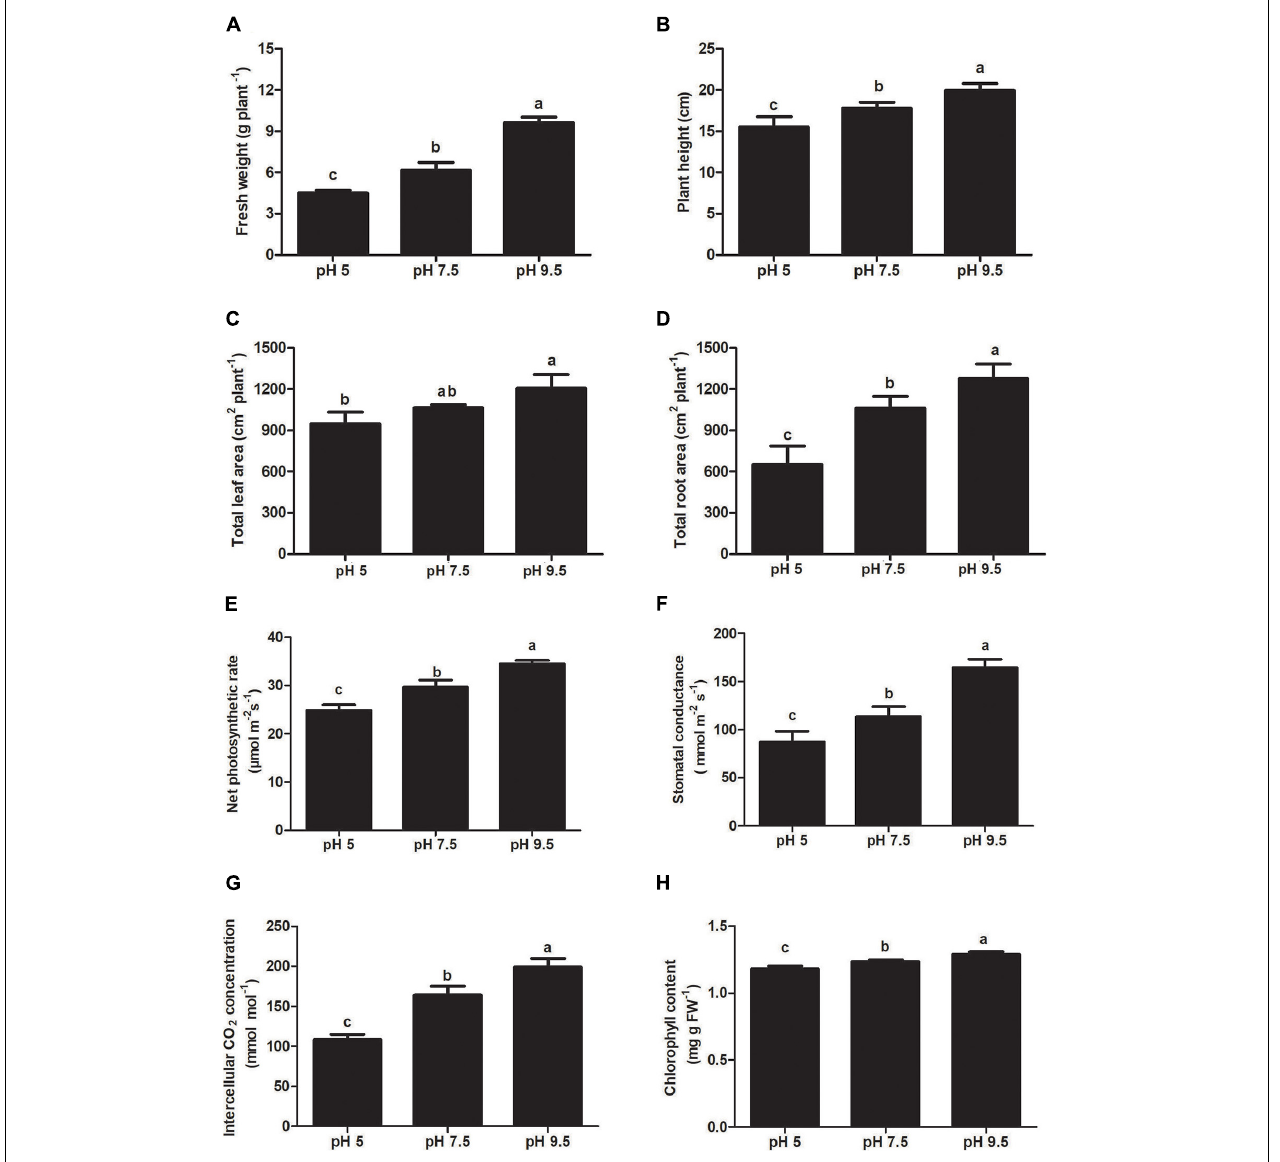
FIGURE 2 | Effects of soil pH on fresh weight (A) , plant height (B) , leaf area (C) , and total root length (D) , net photosynthetic rate (E) , intercellular CO2 concentration (F) , stomatal conductance (G) , and chlorophyll content (H) in sugar beet. Values represent the means of three biological replicates. Different letters indicate significantly different at p <